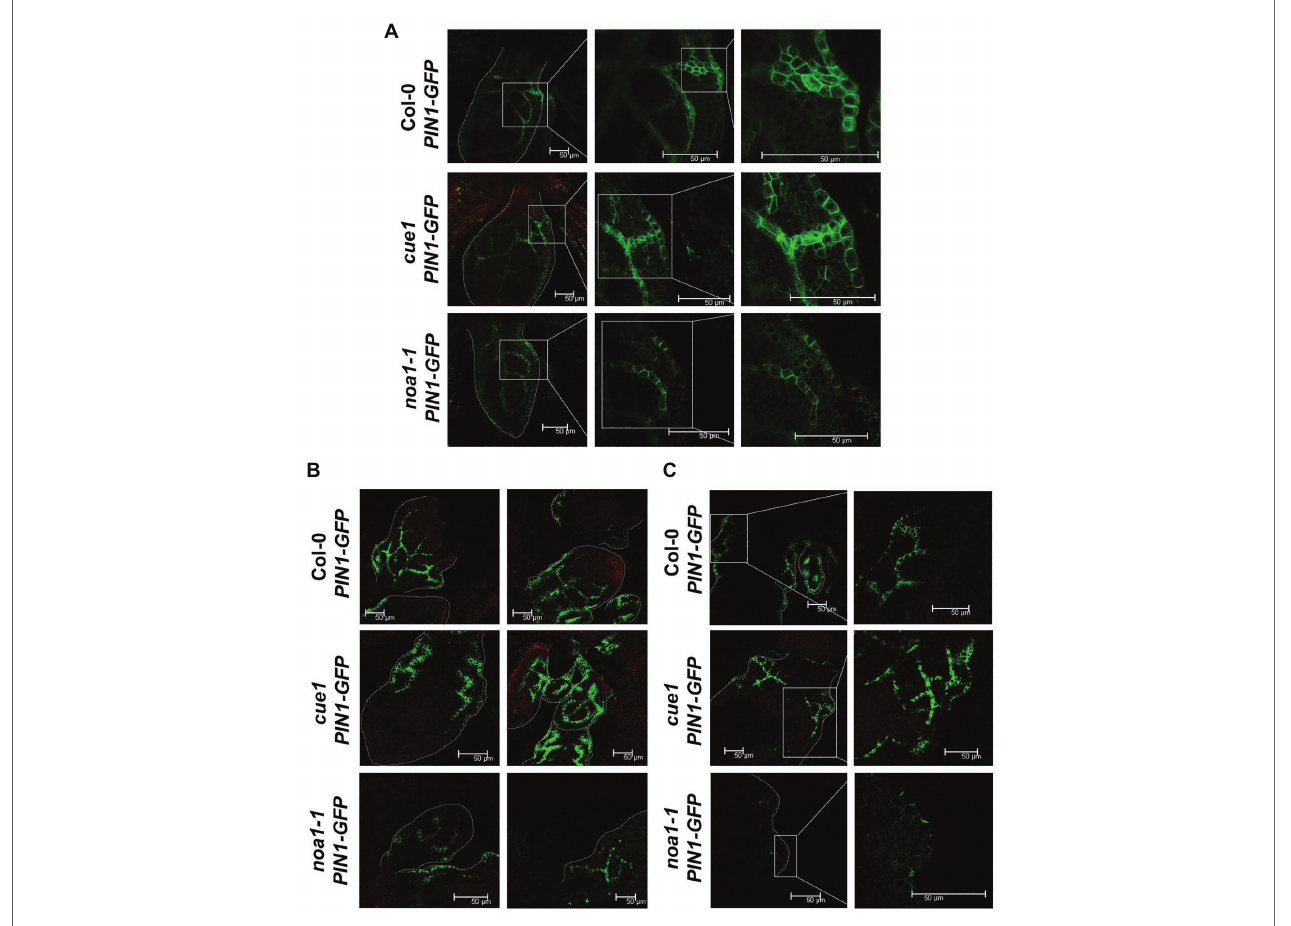
FIGURE 7 | Distribution of PIN1 in aerial parts of NO homeostasis mutants. Confocal micrographs showing the expression of pPIN1:PIN1-GFP in A. thaliana grown in vitro seedlings first or second leaf margin (A) , in sixth and seventh leaf margin (B) , and in eleventh rosette leaf margin (C) . Col-0; pPIN1:PIN1-GFP, cue1; pPIN1:PIN1-GFP and noa1-1; and pPIN1:PIN1-GFP lines are shown. Scale bars, 50 μ